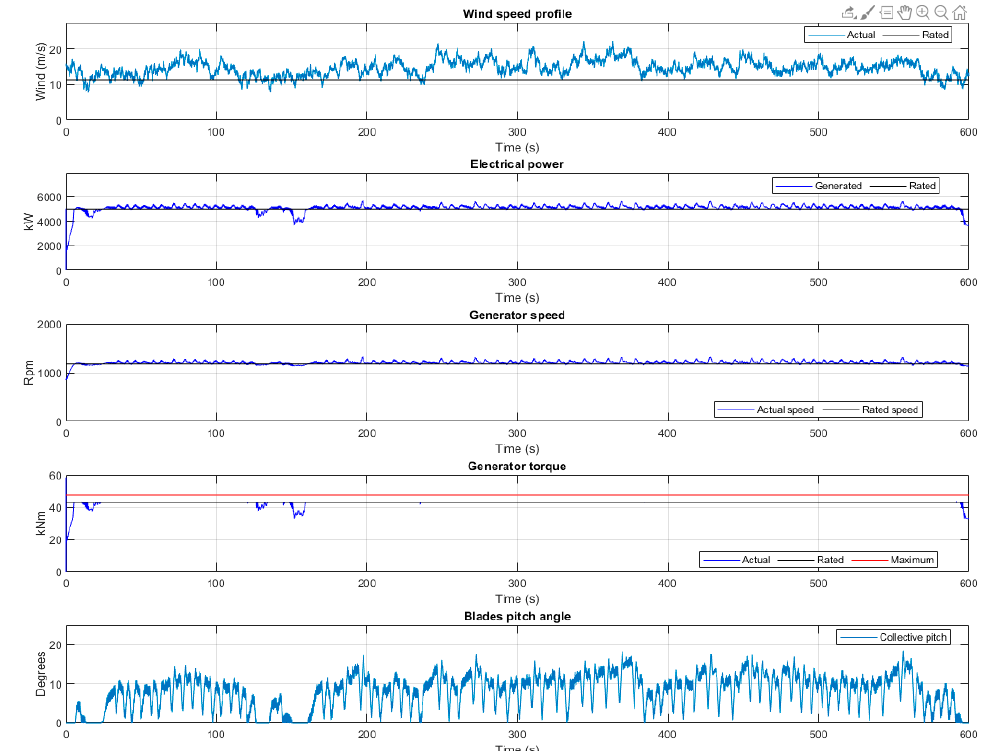
Figure 12. Simulation for improved PI with the Fuzzy Supervisor Control, under a wind profile of average speed of 15 m/s and turbulence A.